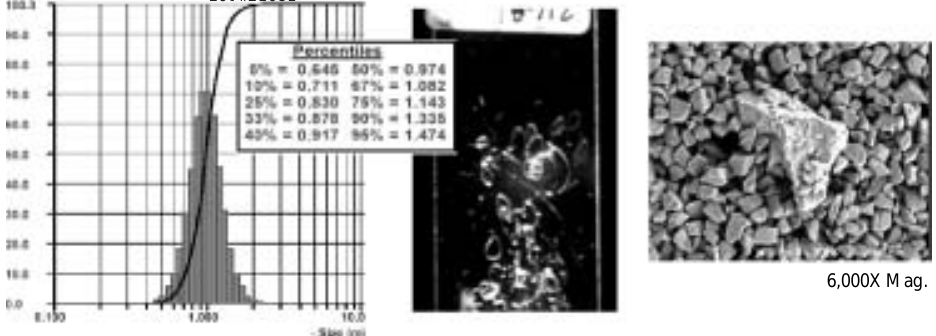
A.) Diamond powder with low-level oversize particles that are undetected by laser light scattering but cause severe scratching.